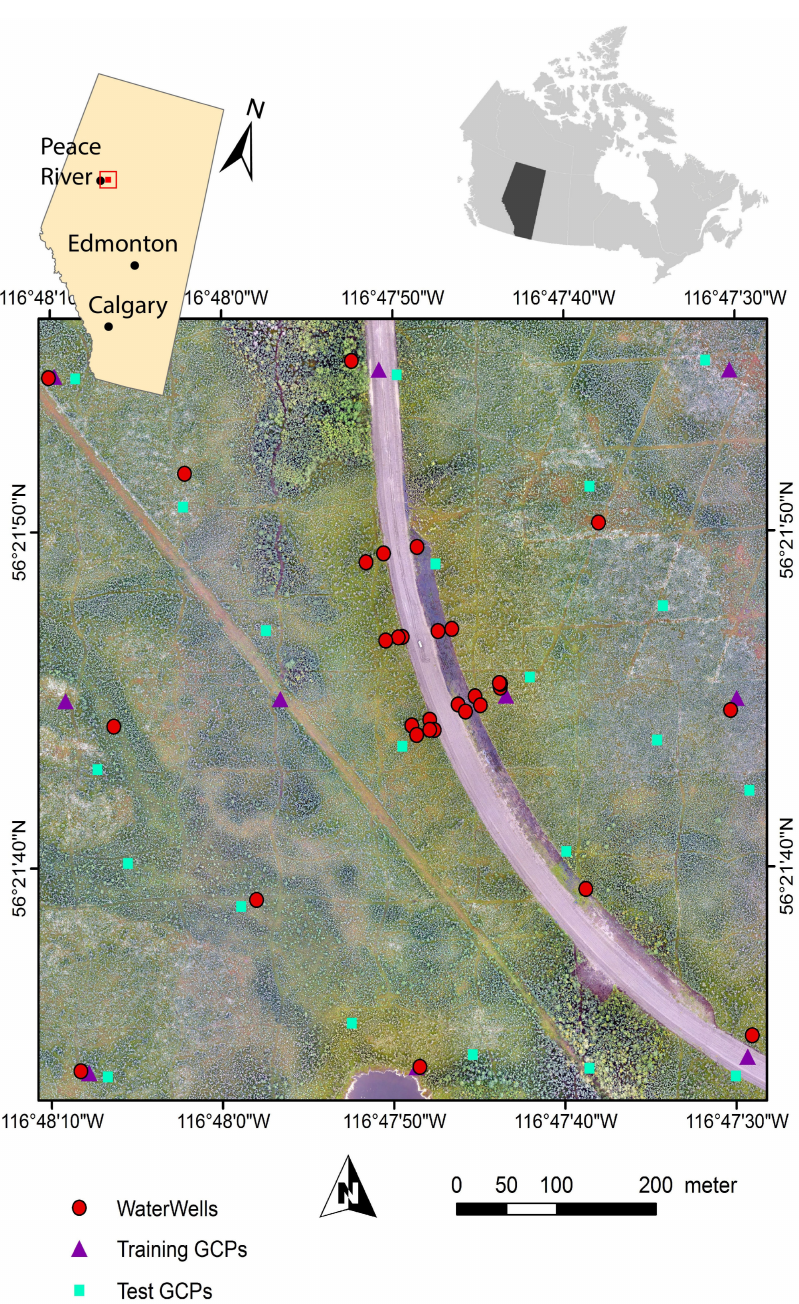
Figure 1. Location and overview of the study area in northern Alberta,